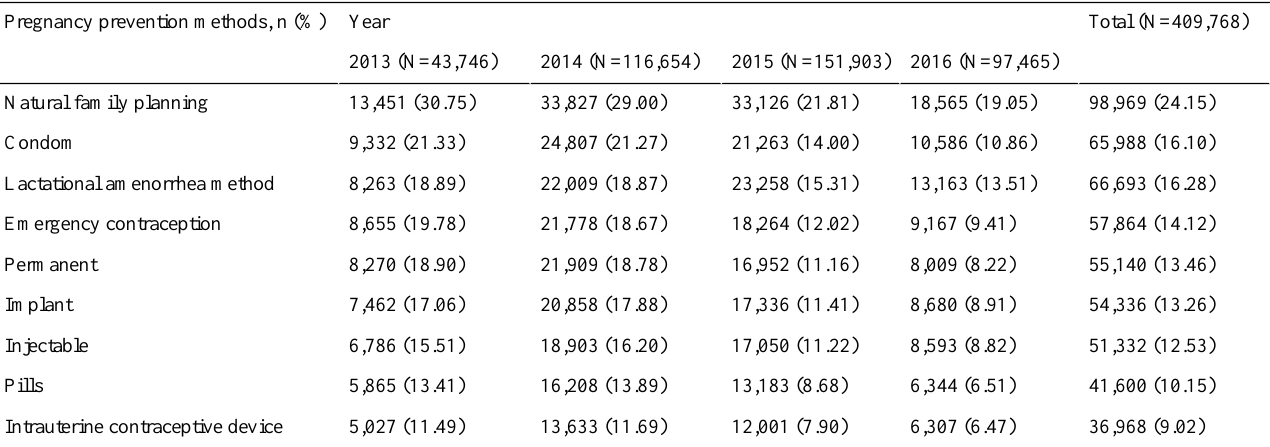
Table 6. Information requested on different pregnancy prevention methods among unique